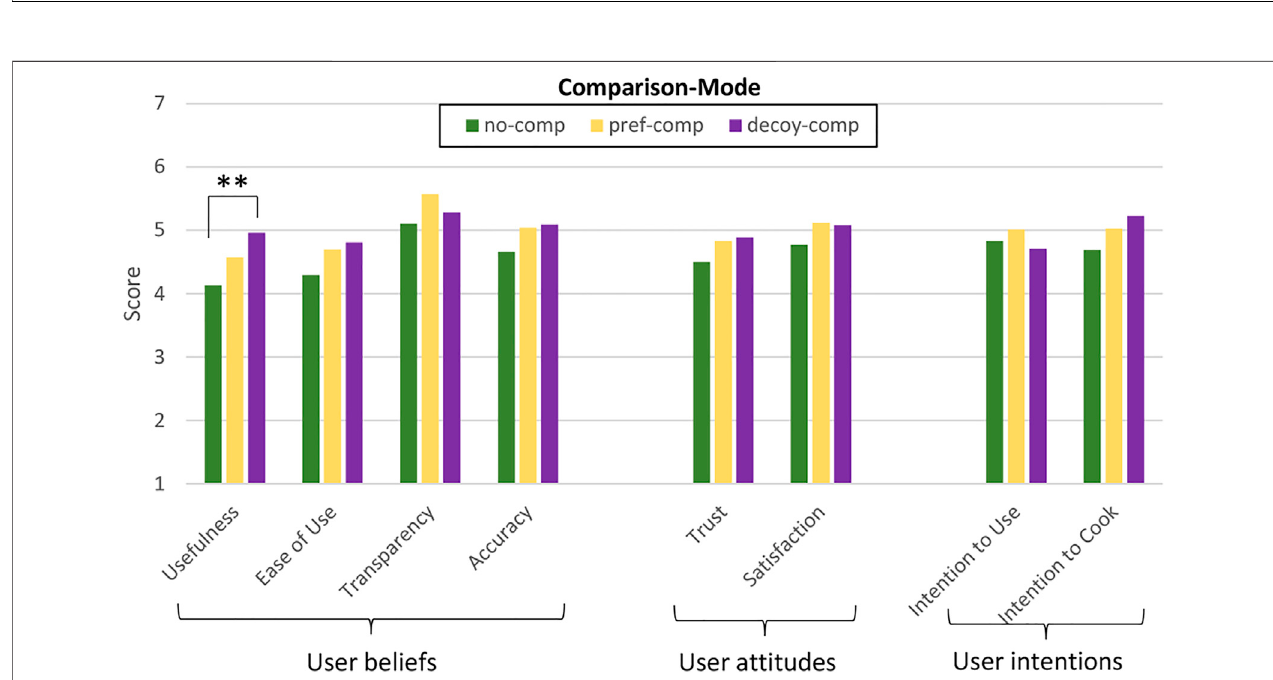
FIGURE 8 | In fl uence of the comparison mode on user beliefs and user attitudes. The differences between the means are marked according to their level of signi fi cance (* for p < .05, and ** for p < .01).